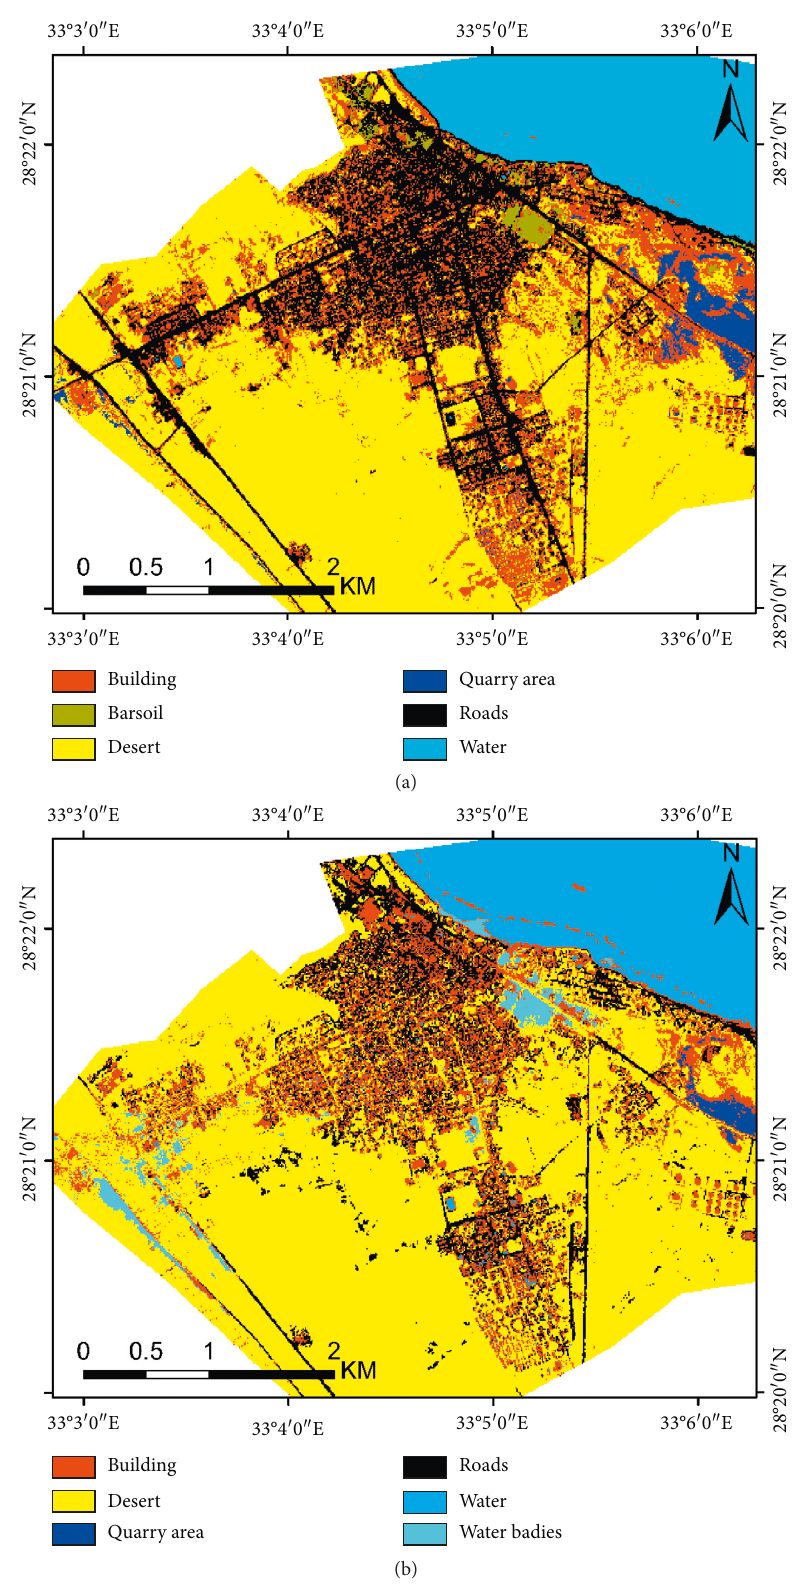
Figure 8: The classified images: (a) before flash flood and (b) after flash